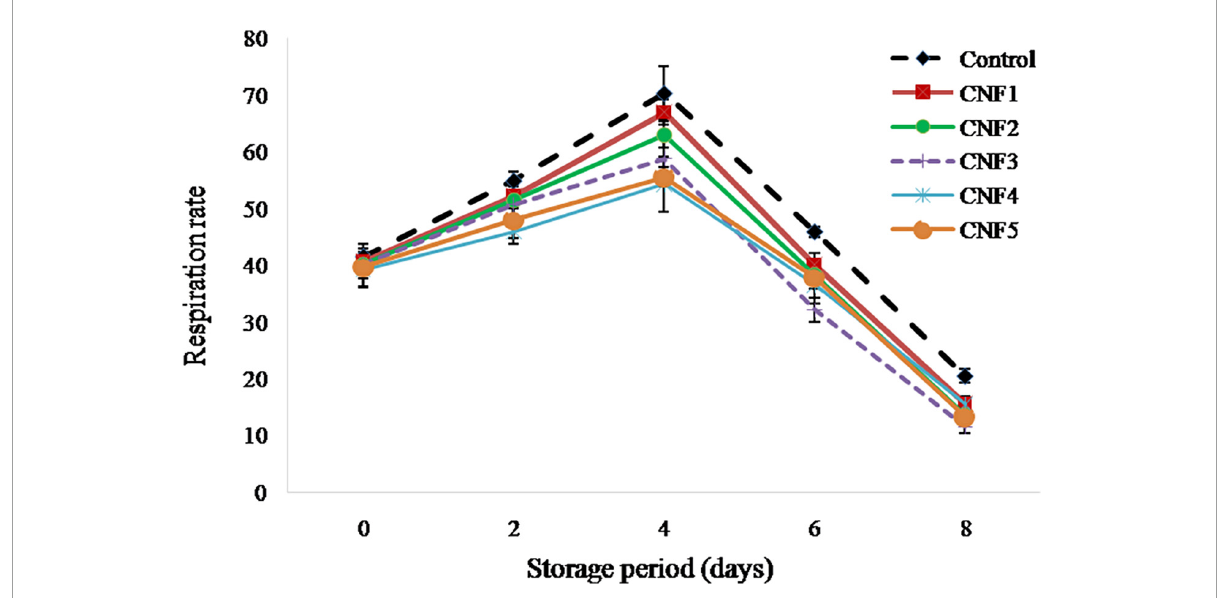
FIGURE3 Respiration rate of sapota fruits stored in corrugated fibre board boxes with CNF during storage at 26 ± 2 ◦